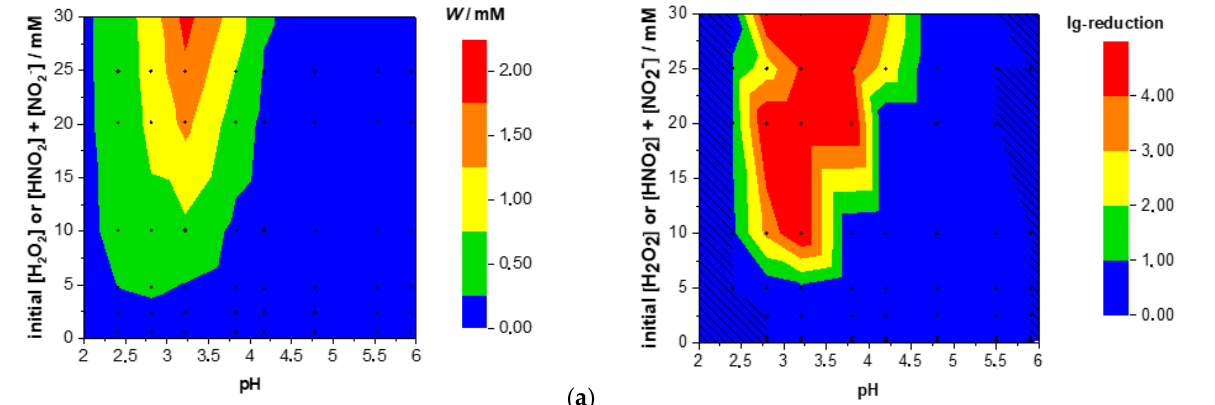
Figure 3. Measured log 10 reduction factors of E. coli of individual experiments ( a ) at indicated pH and initial [H 2 O 2 ] ˆ = [HNO 2 + NO 2 − ] and ( b ) computed efficacy parameter W at indicated pH and initial [H 2 O 2 ] ˆ = [HNO 2 + NO 2 −